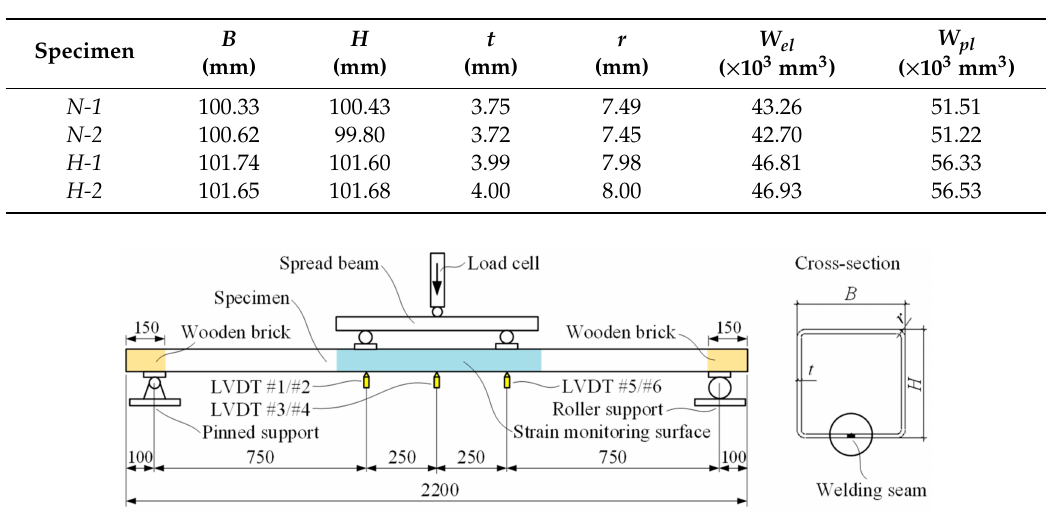
Figure 3. Loading scheme and cross-section of the beam specimen.